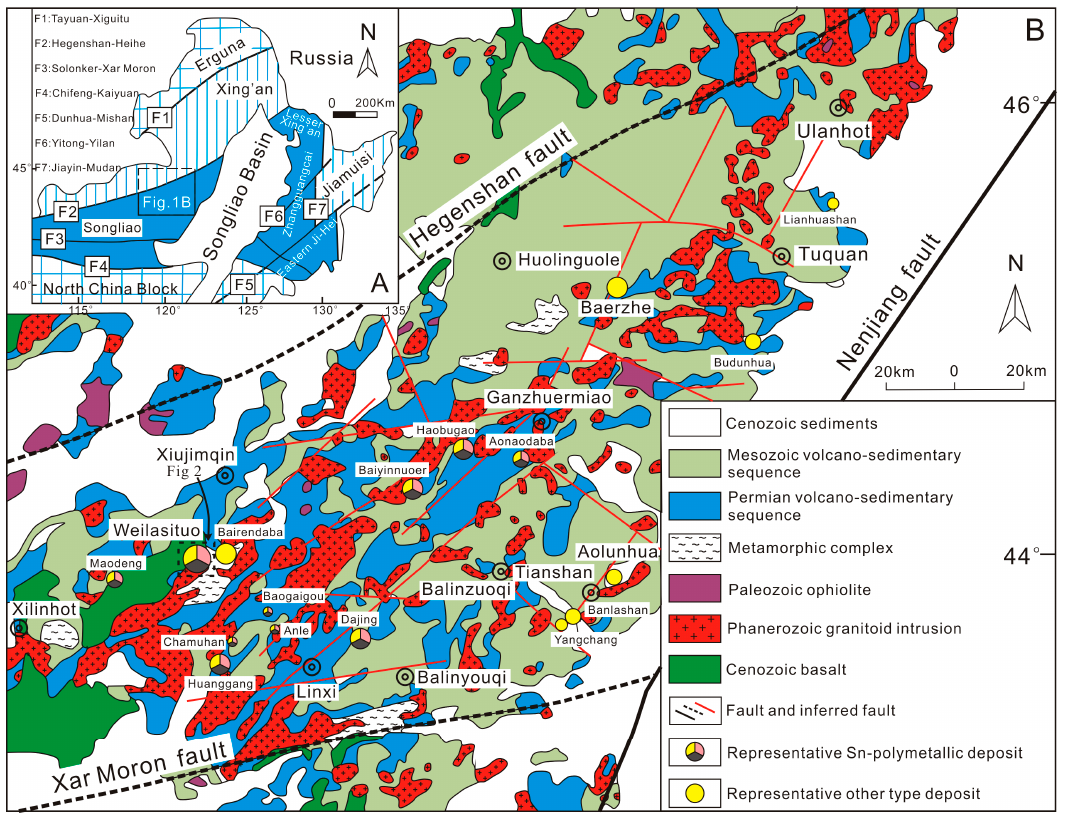
Figure 1. ( A ) Tectonic map of northeastern China (modified after [25]). ( B ) Simplified geologic map of the southern Great Xing’an Range (modified after [26] ).